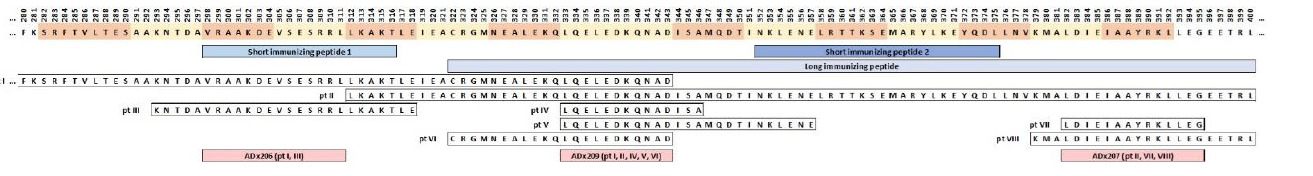
Figure 1. Specificity of ADx206 and ADx209. ( A ) SDS-PAGE of the native neurofilament proteins; 2 µg of protein was loaded in each lane. ( B ) Western blot evaluation of the reactivity of ADx206, ADx209, and ADx207 antibodies to native neurofilament proteins; 200 ng of each protein was loaded on the gel. Each blot contained the protein ladder (PL), Nf-L, Nf-M, Nf-H, α -internexin ( α -int), and, finally, peripherin (Per). ADx206 and ADx209 are highly specific antibodies with no cross-reactivity to Nf-M, bNf-H, α -internexin, or peripherin. ADx207 antibody shows cross-reactivity with bNf-M, α -internexin, and the peripherin protein. The unloaded lanes in the gel and the blots have been cropped.